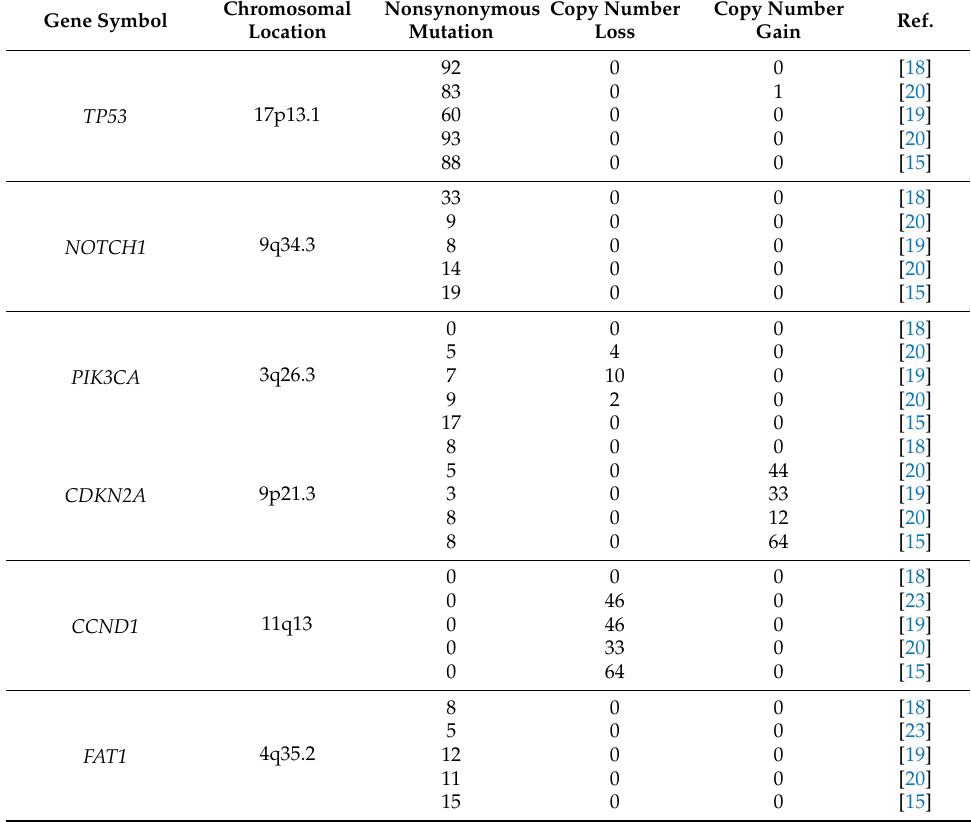
Table 2. The mutational profiles of important genes in OSCC as established in various